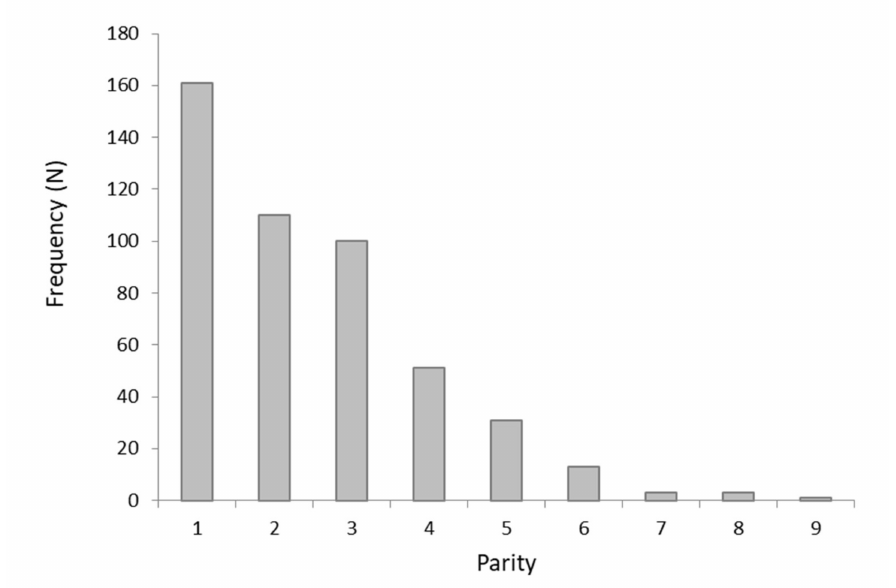
Figure 1. Distribution of parity.